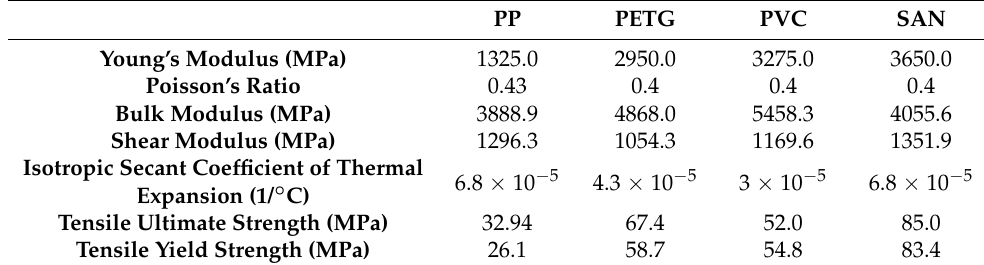
Table 1. Properties of PP, PETG, PVC and SAN plastics